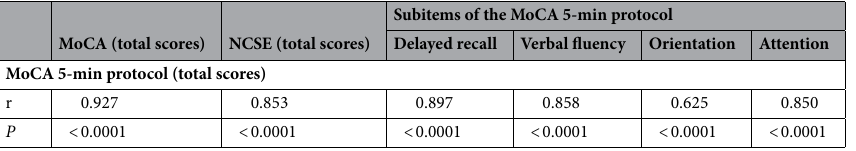
Table 1. Summary of correlation analyses (MoCA 5-min protocol). MoCA, Montreal Cognitive Assessment; MoCA 5-min Protocol, Montreal Cognitive Assessment 5-minute Protocol.